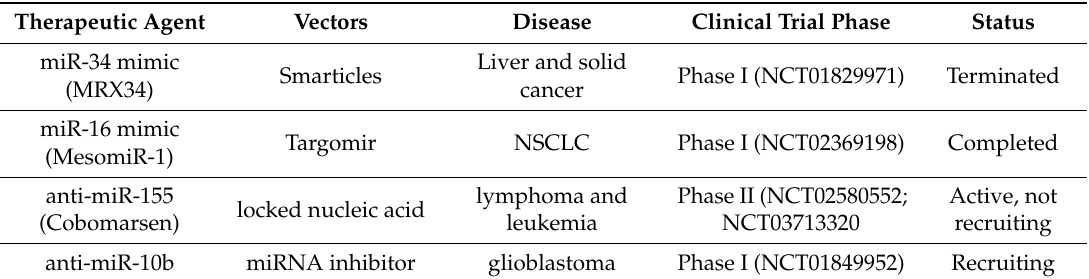
Table 1. Clinical trials using miRNAs as therapeutic